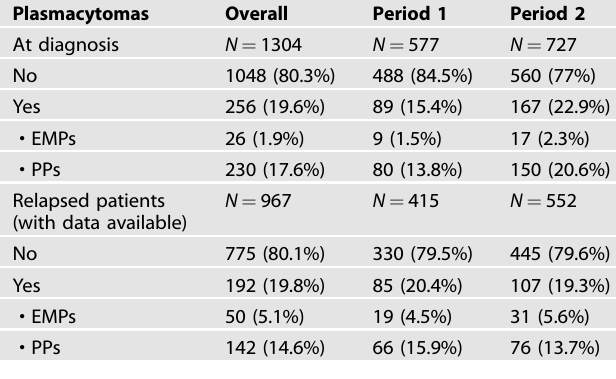
Table 2. Incidence of plasmacytomas overtime at diagnosis and at fi rst relapse.